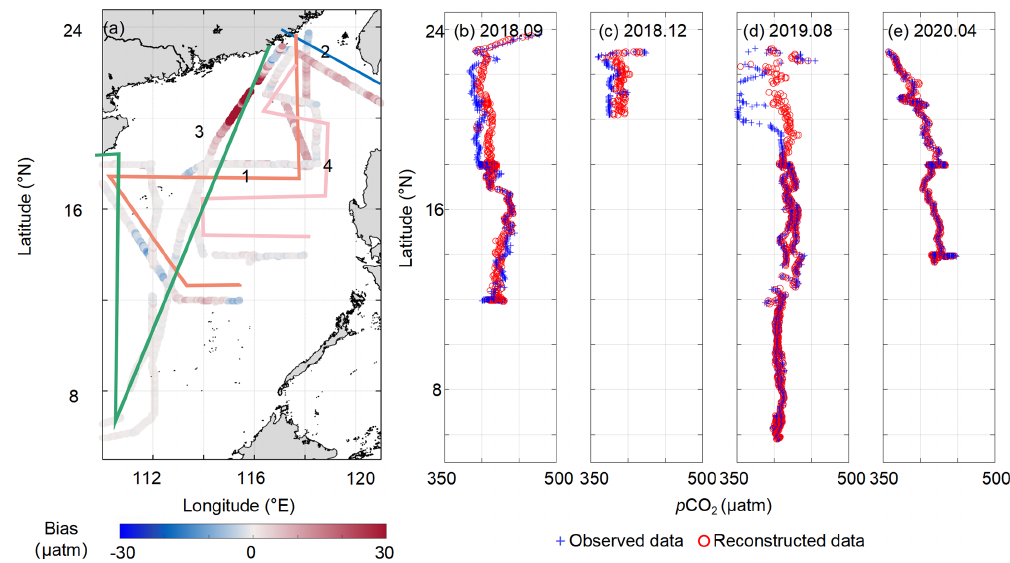
Figure 9. Difference between the reconstructed p CO 2 data and four independently tested in situ datasets during the four seasons. In panel (a) ,